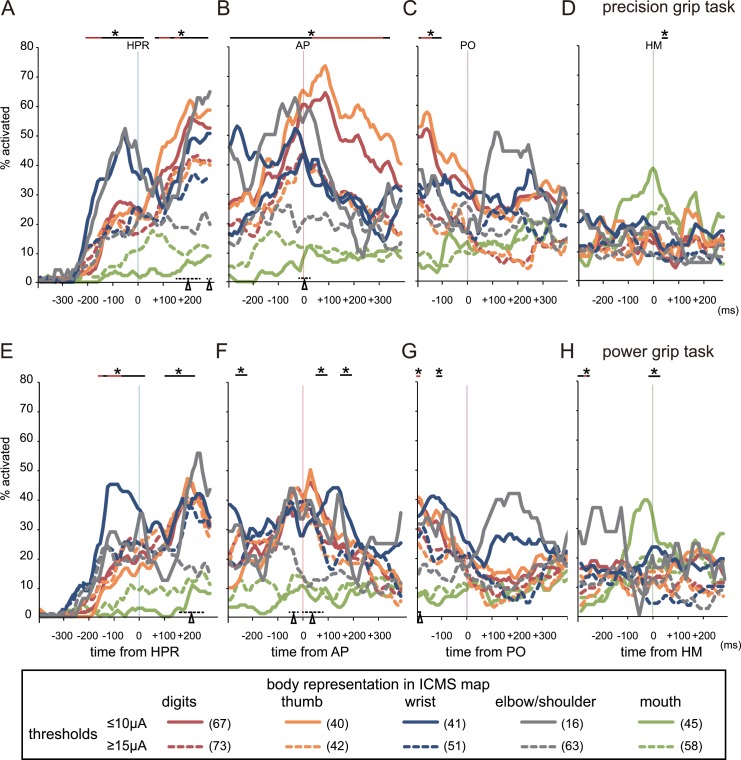
Percentage of neurons in each body representation of the intracortical microstimulation (ICMS) map in the primary motor cortex (M1) activated during the course of the task.(A–D) Precision grip task. (E–H) Power grip task. Neuronal firing rates were aligned to the time of homepad release (HPR: A, E), approaching the target (AP: B, F), pulling the target out (PO: C, G), and bringing the hand to the mouth (HM: D, H). Each line color represents a different body representation, and the solid and dashed lines show the results of lower threshold (LT) and higher threshold (HT) neurons located at recording sites with movement thresholds of 10 μA or less, and at least 15 μA, respectively. The number of neurons in each category is shown in parentheses. Chi-square tests were performed to test the null hypothesis that there is no association between the body representation and percentage of neurons activated, not only among the five body representations—digits, thumb, wrist, elbow/shoulder, and mouth—but also the four forelimb representations, excluding the mouth. The asterisks and solid lines at the top of the graphs indicate bins in which LT neurons in each of five representations were differentially activated (P < 0.01, chi-square test). The red lines indicate the bins in which LT neurons in each forelimb representation (i.e., without the mouth representation) were differentially activated (P < 0.01, chi-square test). Similarly, the black triangles and dashed lines at the bottom of the graphs indicate the 10-ms bins in which HT neurons in each representation including the mouth and each forelimb representation were differentially activated (P < 0.01, chi-square test). This analysis shows that populations of LT neurons in each body representation were differentially activated during reach-grasp-retrieval movements.